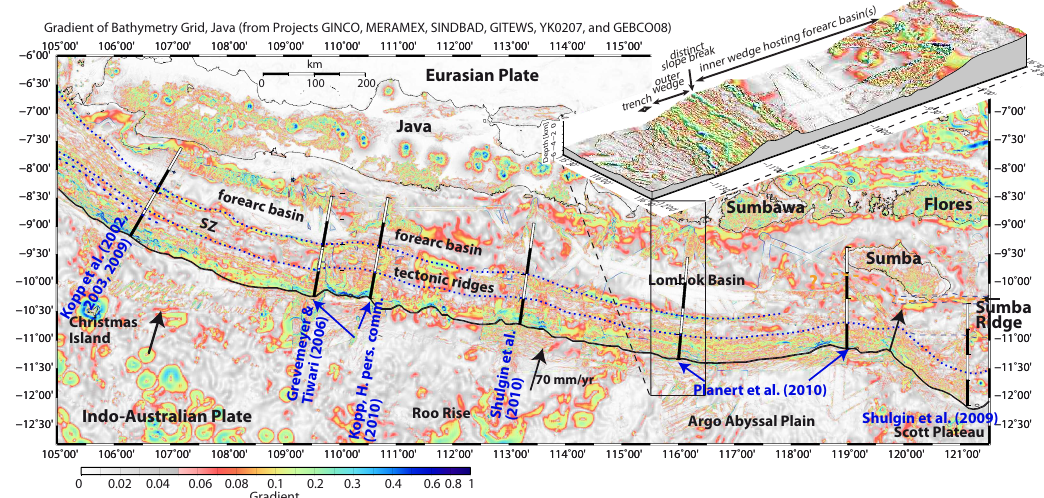
Fig. 5. Gradients of bathymetric data off Java and the Lesser Sunda islands. Annotations and details as described in Fig. 3. Blue dashed lines mark the updip and downdip limits of the SZ, here. Inset shows close-up of representative area off Lombok island (same region as shown in Fig. 6). Gradients are draped on perspective view of bathymetry relief. Trench, outer wedge, slope break and inner wedge are